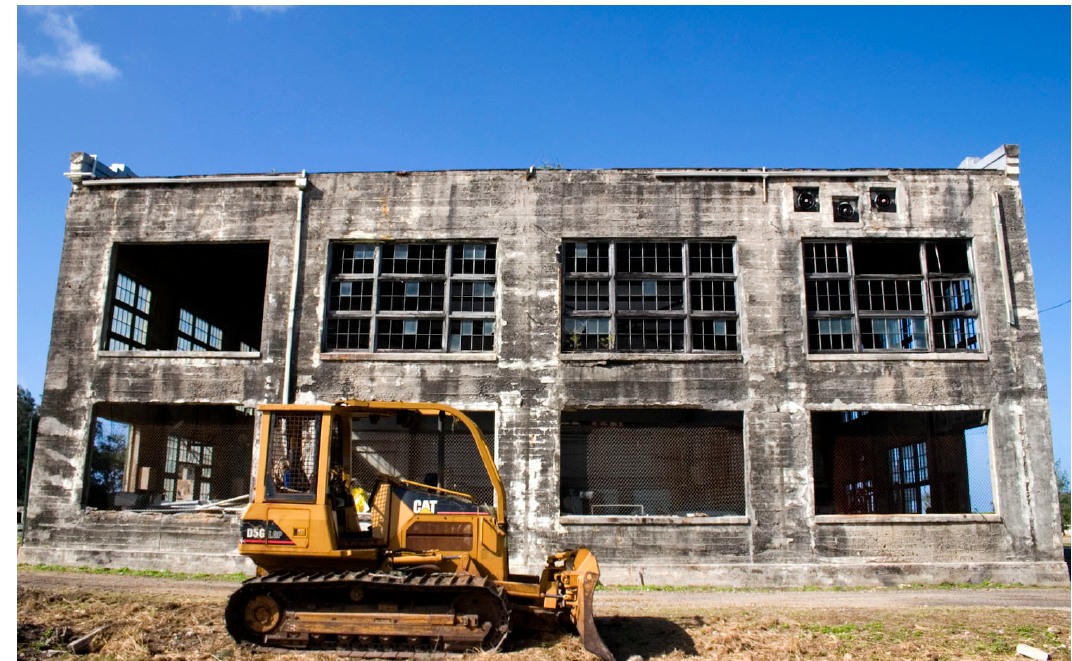
Figure 1.2: Remnants of Marconi facility at Kahuku: views of operational building facade. Image: Jonathan Haeber, Flickr, Creative Commons Attribution